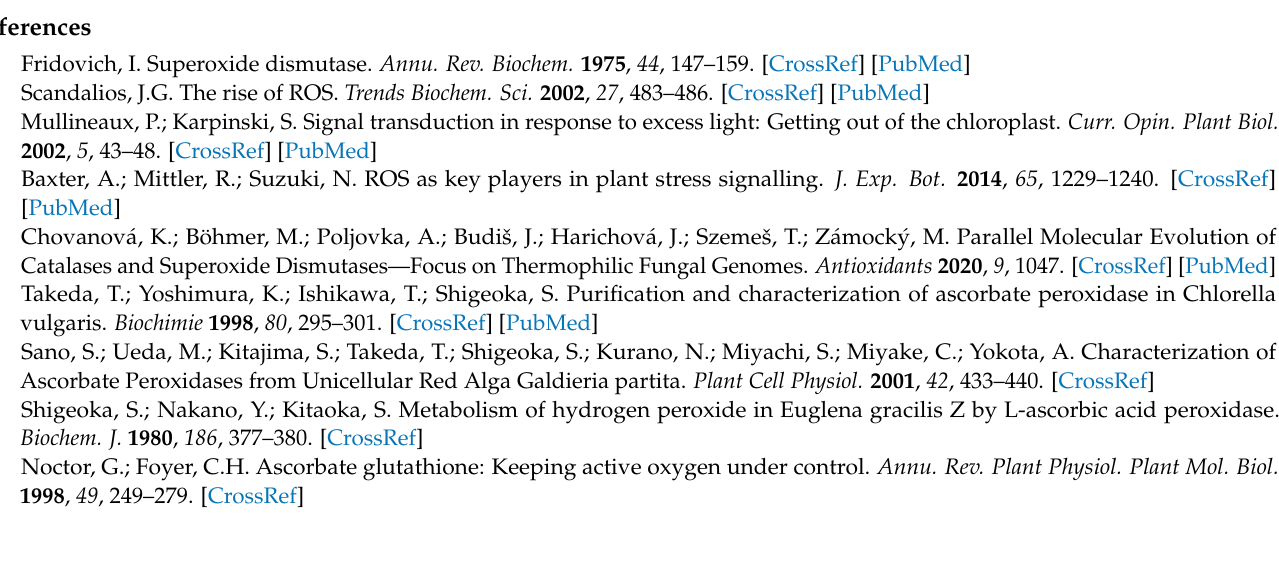
(Os); Figure S6: Sequence logos for the conserved motifs of DHAR from Ricinus communis , Arabidopsis thaliana and Oryza sativa ; Figure S7: Structure and protein sequence analysis of GR family in Ricinus communis (Rc), Manihot esculenta (Me), Jatropha curcas (Jc), Hevea brasiliensis (Hb), Arabidopsis thaliana (At) and Oryza sativa (Os); Figure S8: Sequence logos for the conserved motifs of GR from Ricinus communis , Arabidopsis thaliana and Oryza sativa ; Figure S9: Cis-regulatory elements in the APX , MDAR , DHAR , and GR promoter regions from Ricinus communis , Manihot esculenta , Jatropha curcas , and Hevea brasiliensis ; Figure S10: miRNA targeting RcAPX , RcMDAR , RcDHAR , and RcGR genes; Table S1: APX, MDAR, DHAR and GR sequences from rice and arabidopsis used as bait to BLASTp analysis; Table S2: Sequences of primers used in RT-qPCR experiments; Table S3: Physicochemical parameters and subcellular predictions from APX in Ricinus communis , Manihot esculenta , Jatropha curcas , Hevea brasiliensis ; Table S4: Physicochemical parameters and subcellular predictions from MDAR in Ricinus communis , Manihot esculenta , Jatropha curcas , Hevea brasiliensis ; Table S5: Physicochemical parameters and subcellular predictions from DHAR in Ricinus communis , Manihot esculenta , Jatropha curcas , Hevea brasiliensis ; Table S6: Physicochemical parameters and subcellular predictions from GR in Ricinus communis , Manihot esculenta , Jatropha curcas , Hevea brasiliensis ; Table S7: Conserved miRNAs targeting AsA-GSH genes in castor